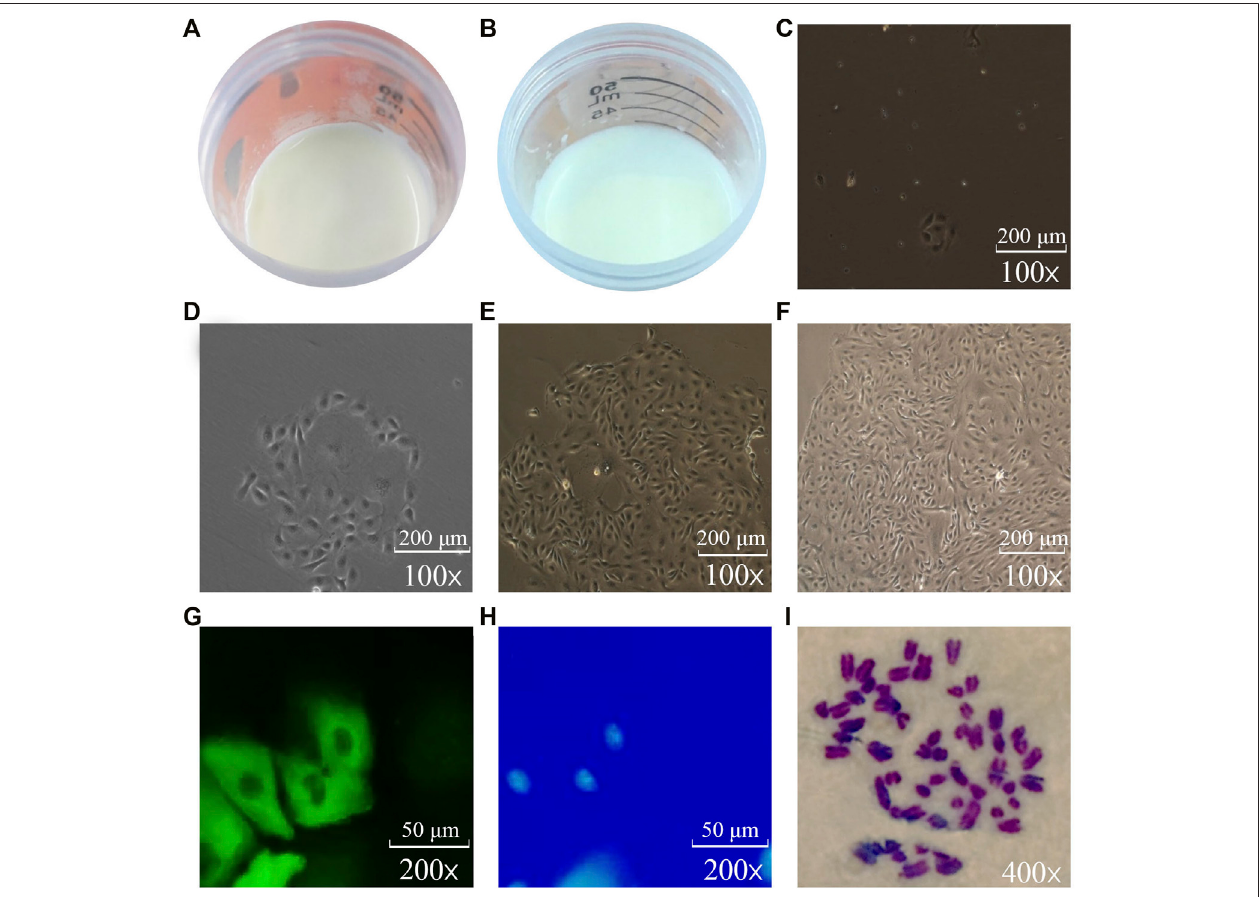
FIGURE 1 | Isolation, culture and identi fi cation of BMECs ( C – F : 10*10; G, H : 10*20; I : 10*40). (A) : Thickness and area of milk fat layer after centrifugation of high- milk fat milk. (B) : Thickness and area of milk fat layer after centrifugation of low-milk fat milk. (C) : Single-cell clone of BMECs can be seen after 3 days of isolation and culture. (D) :Single-cellclonesofBMECsgraduallyexpandafter5 daysofculture. (E) :BMECshavebeguntoproliferaterapidlyafter7 days. (F) :After13 daysofisolation andculture,BMECscanberapidlycoveredwiththebottomofthebottle. (G) :BMECslabeledwithgreen fl uorescence. (H) :NucleistainedbluebyDAPIinthesame visual fi eld. (I) : Chromosomes under oil